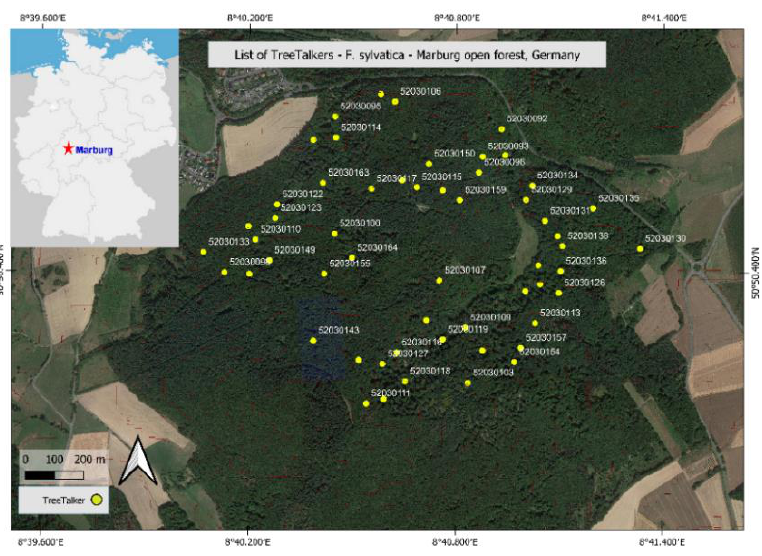
Figure 7. Map of the study area, Marburg Open Forest (MOF), showing the location of the mounted TreeTalkers on beech trees. Table 1. Height, diameter at breast height (DBH), sapwood area, and canopy volume for the selected trees for individual responses.